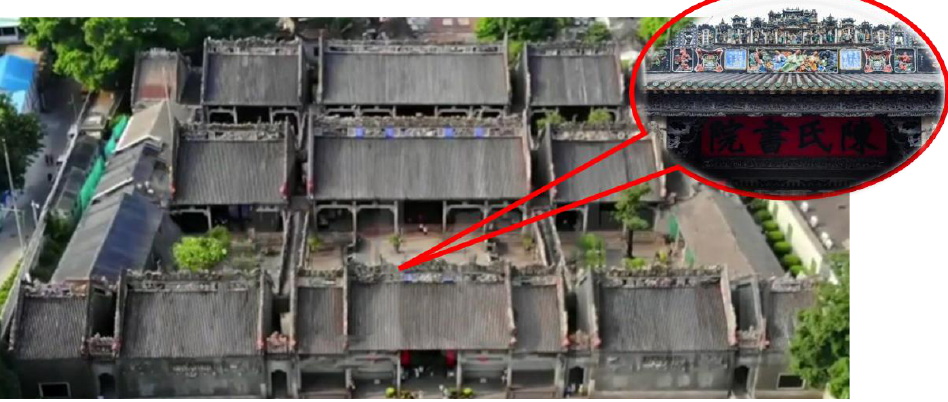
Figure 14. The Chen Clan Temple.